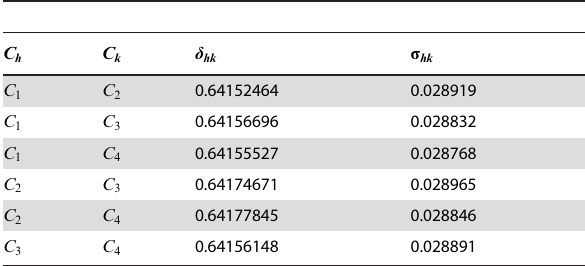
Table 2. Scenario 1A average between distance and relative standard deviation for communities simulated with b ~ 50 and a ~ 25 .